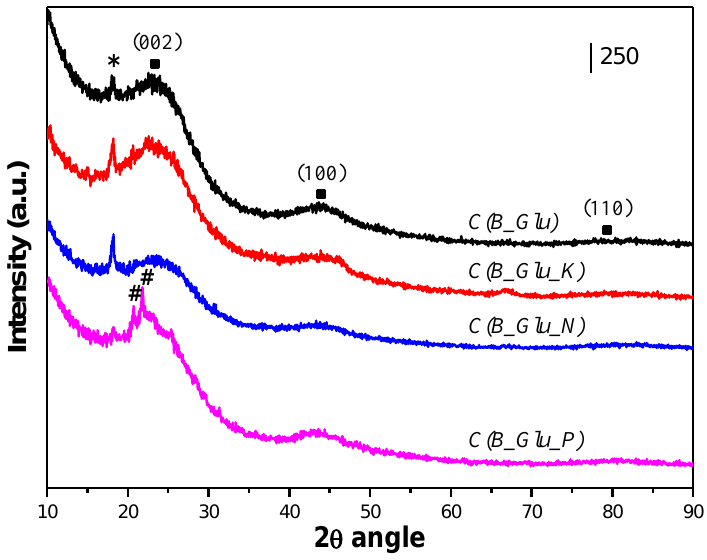
Figure 4. Diffractograms of the synthesized carbons ( ■ carbon, # AlPO 4 , * silicate). Table 1. Structural parameters for the synthesized carbons.